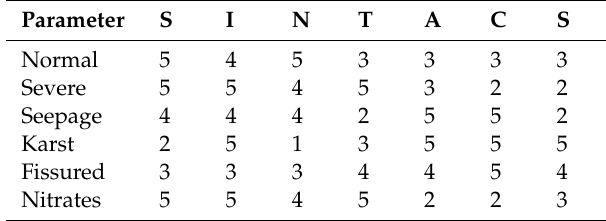
Table 4. Strings of weights in SINTACS (adapted from